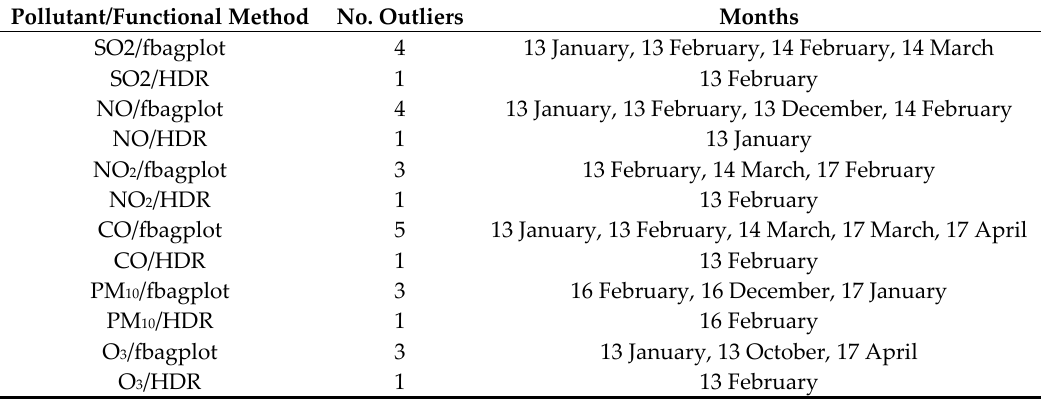
Table 1. Summary of the outliers detected by the two functional procedures from the dataset collected in the Santa Marina air quality monitoring station corresponding to Soto de Ribera coal-fired power plant pollutants emission (years from 2013 to